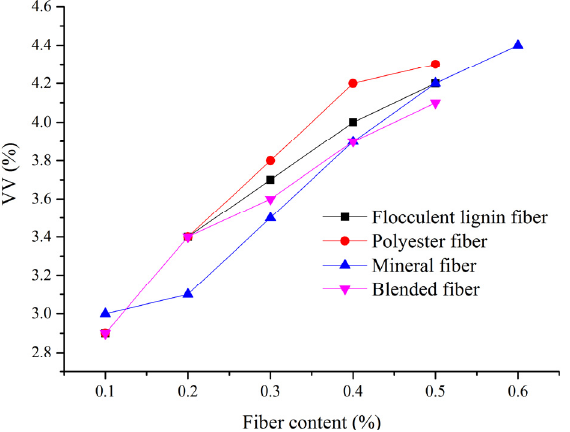
Figure 3. Percent air voids in SMA mixtures with four different fiber types.